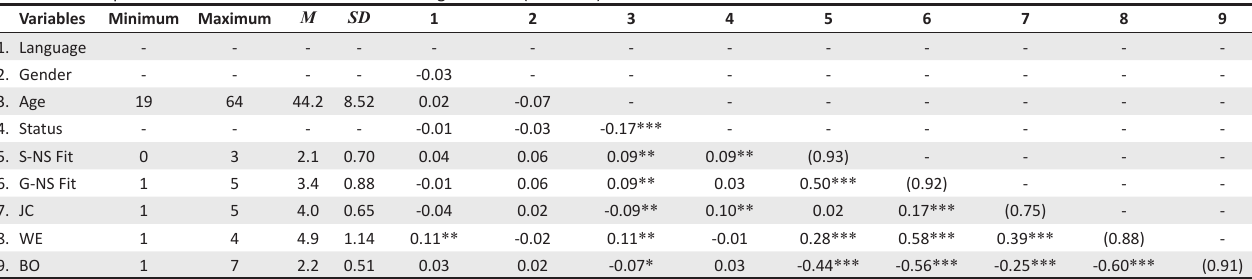
TABLE 4: Descriptive statistics and inter-correlations among variables ( N = 1500).